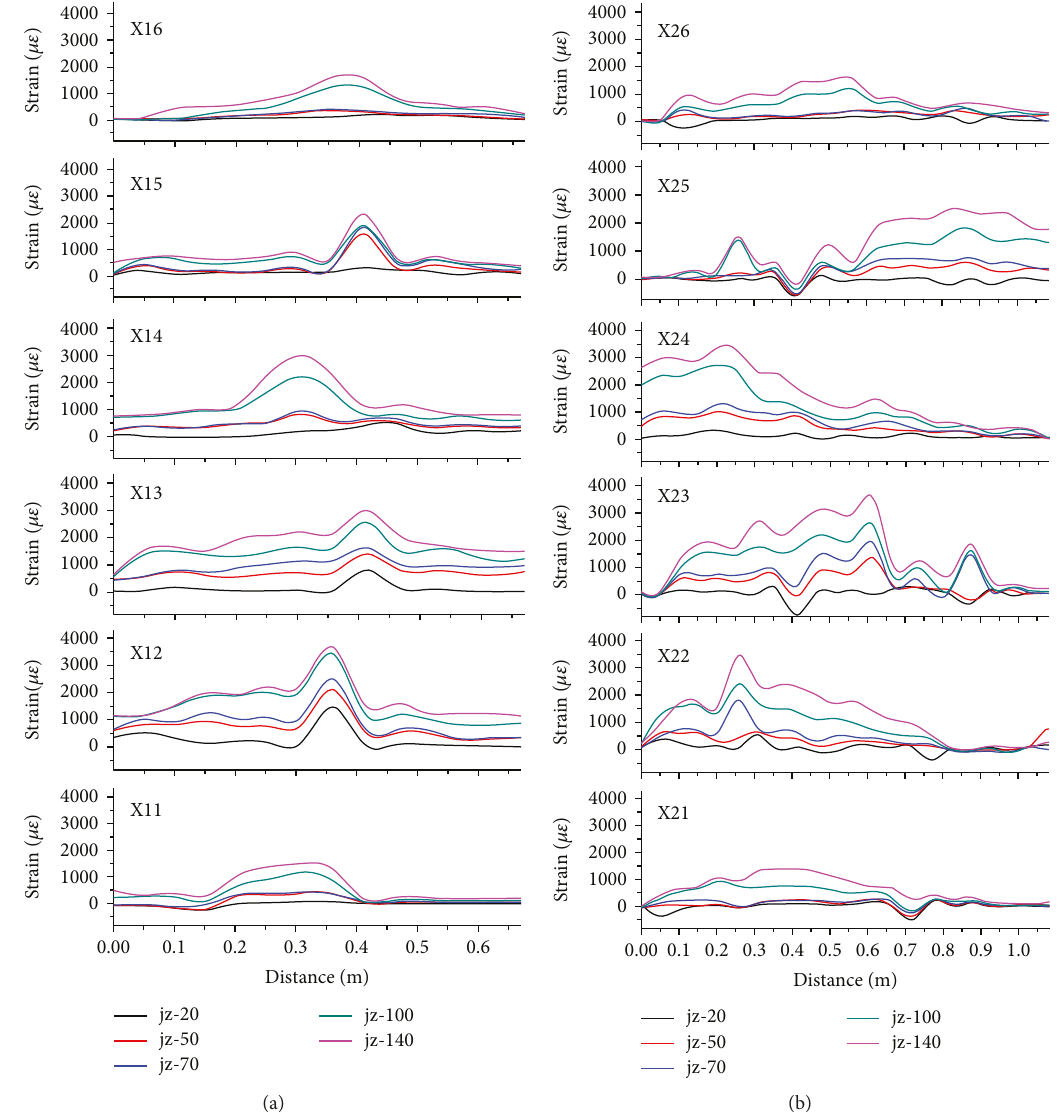
Figure 8: Strain diagram of optical fi bers in the X direction under di ff erent loading conditions. (a, b) Strain diagram of upper and bottom optical fi bers, respectively, in the X direction under di ff erent loading